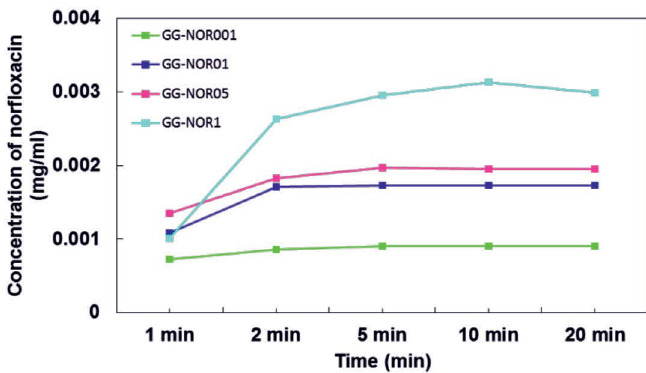
Fig. 4. Graph of releasing property through GG-NOR001, GG-NOR01, GG-NOR05, and GG-NOR1 films.